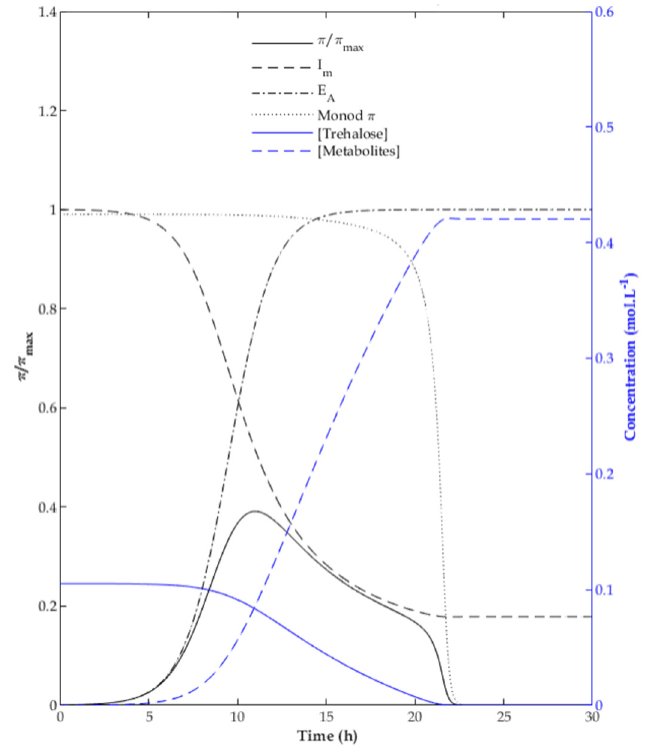
Figure 4. Typical evolution of the relative production rate over